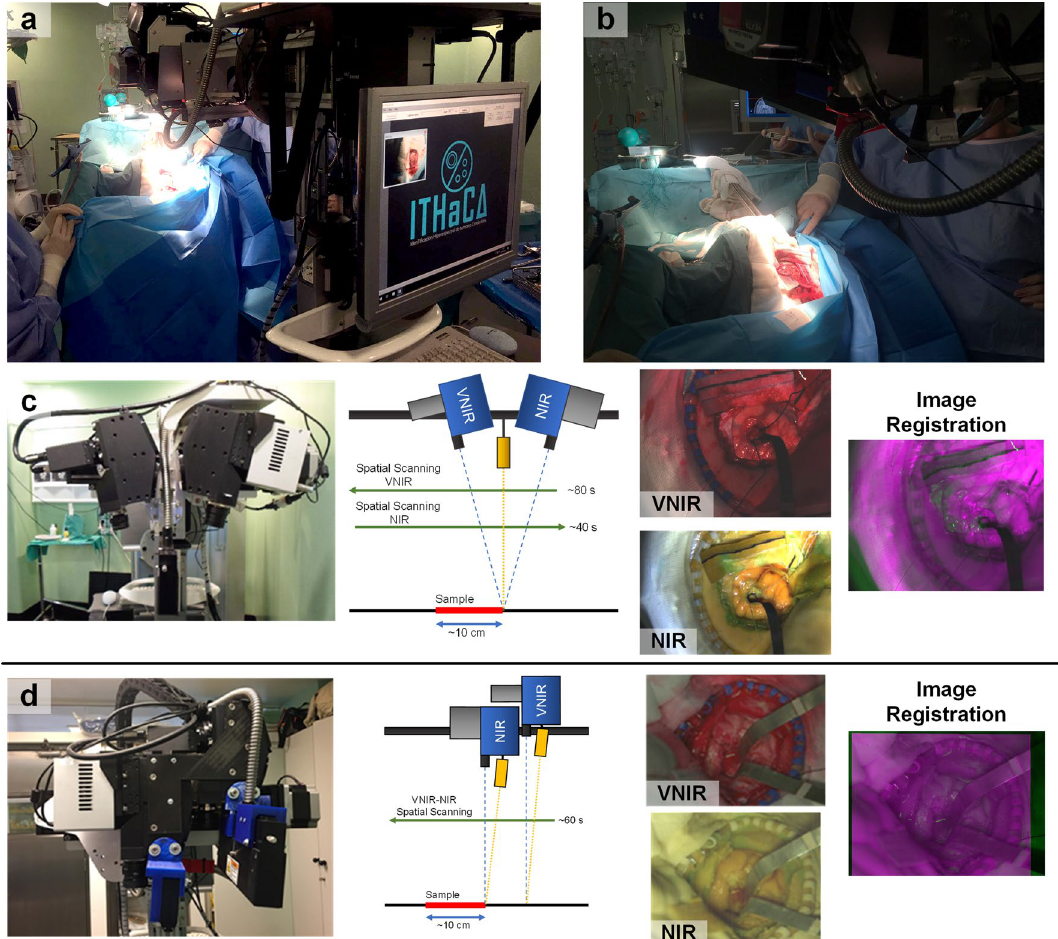
Figure 6. ( a , b ) HS acquisition system being used during a neurosurgical intervention at the University Hospital of Gran Canaria Doctor Negrin (Spain). ( c ) HS cameras orientation of the original demonstrator, examples of pseudo-RGB images of VNIR and NIR HS cubes and their corresponding registration using green (VNIR) and magenta (NIR) false color. ( d ) Proposed configuration with HS cameras placed in parallel and perpendicular to the sample, examples of pseudo-RGB images of VNIR and NIR HS cubes and their corresponding